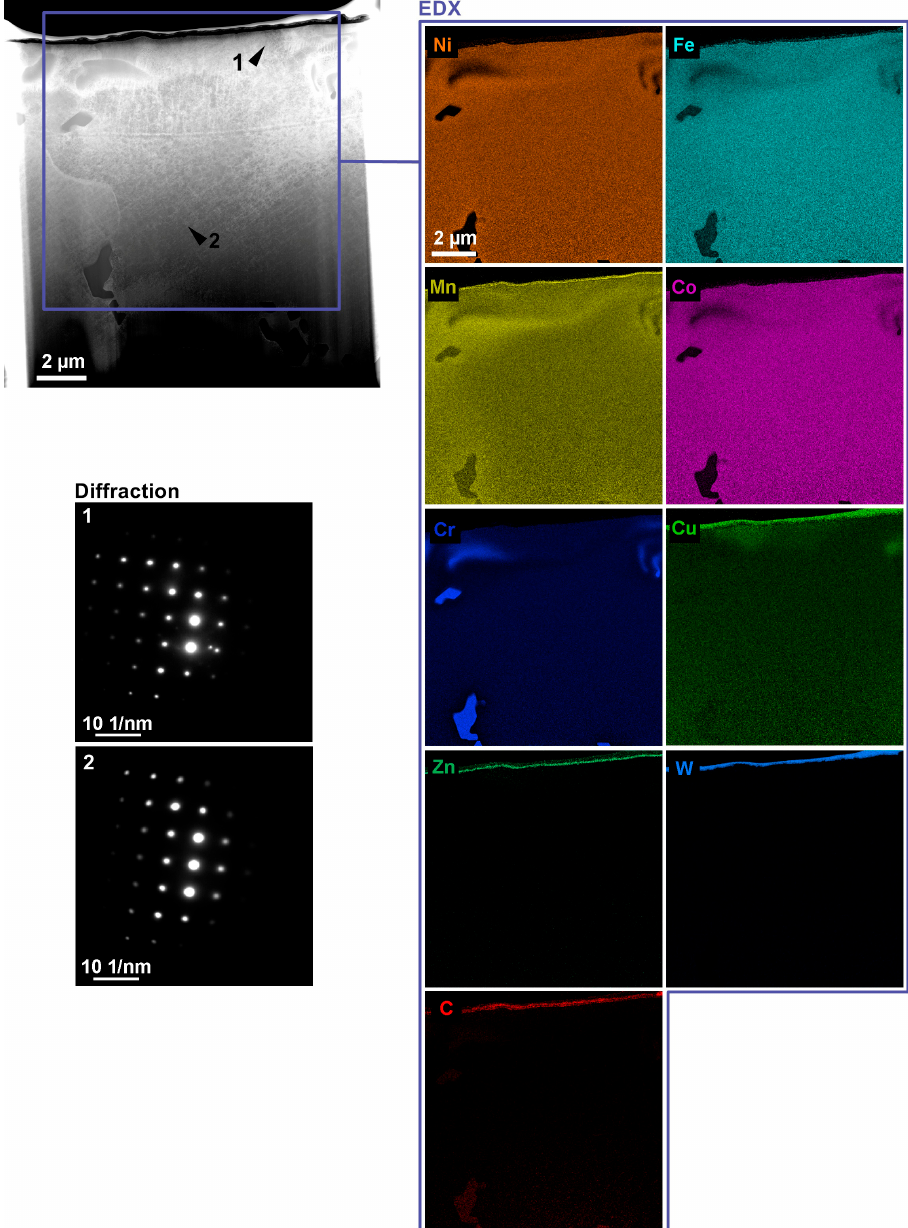
in various details and di ff raction